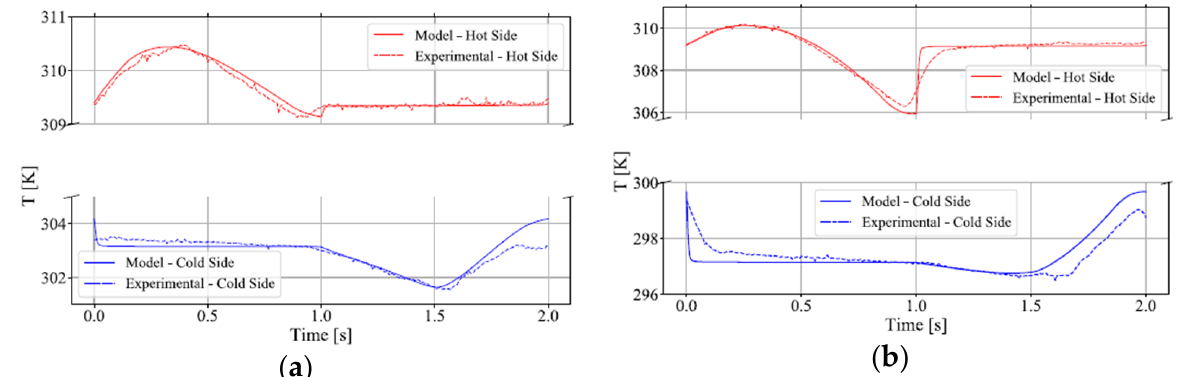
Figure 28. Temperature evolution of both ends of the regenerator and comparison with the experimental values for a mass flow rate and a temperature range of respectively: ( a ) 40 kg/h and 6 K; ( b ) 60 kg/h and 12 K [92].